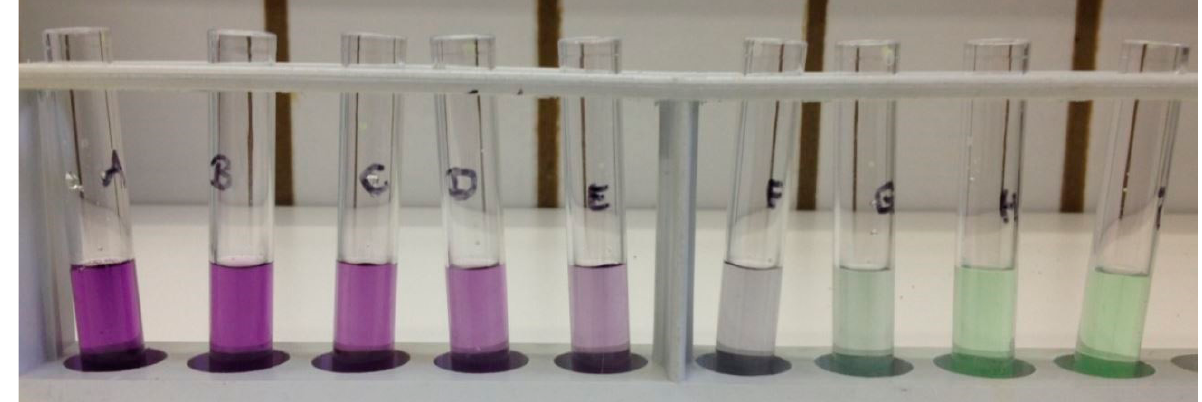
Figure 2. Test tube protocol with a working range of 20–2000 µg/mL (dilution series).